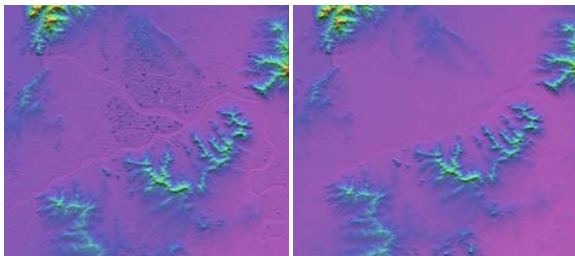
Figure 3. The DSM from the ZY-3(02) (left), DTM from the ZY-3(01) (right)